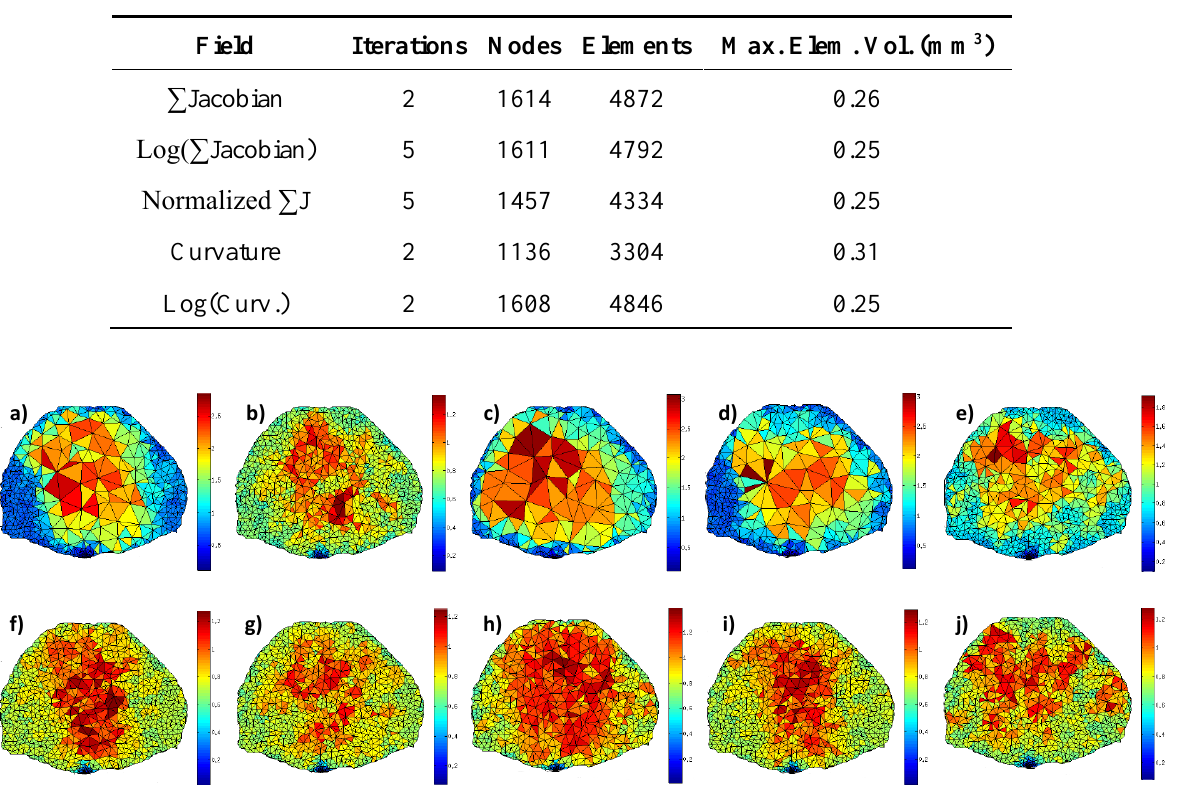
Table 3. Mesh characteristics at convergence under different solution fields.